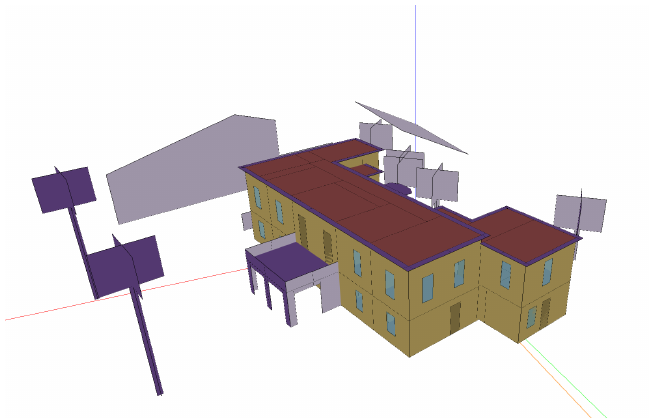
Figure A2. Envelope of the Offices